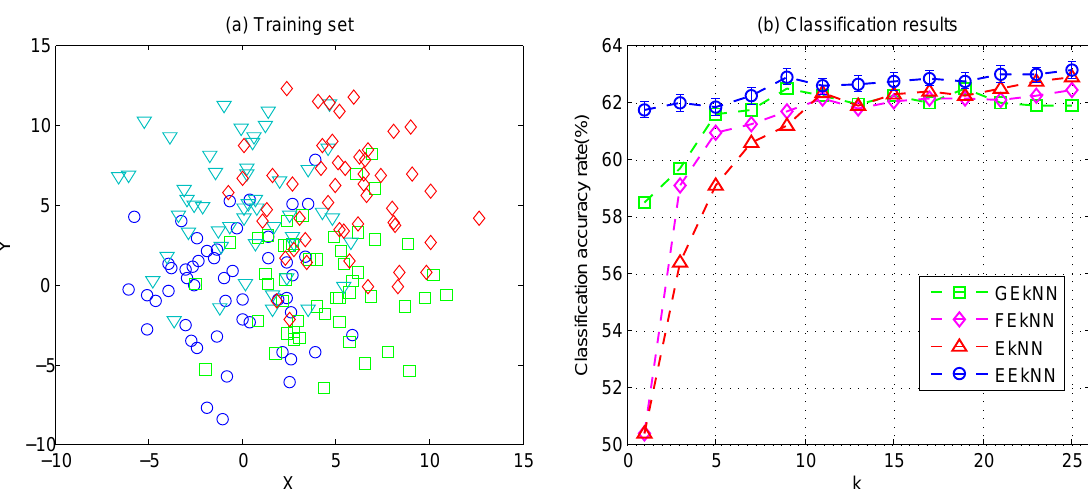
Figure 6. Training set and classification results for Case 2 with imprecision ratio ρ =